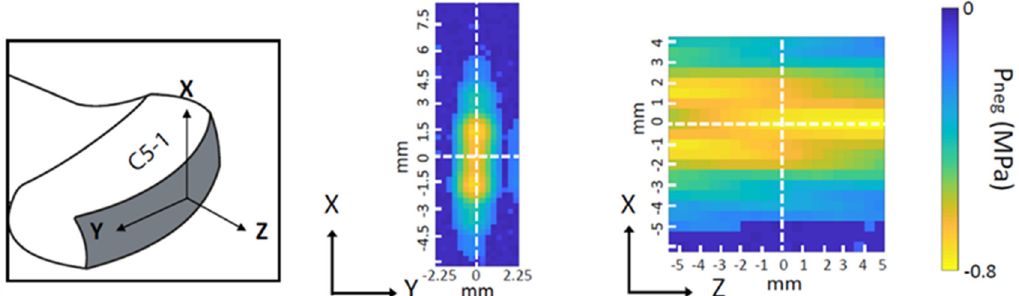
Figure 3. Pressure field maps of the C5-1 probe measured in PW Doppler mode. Middle: transversal plane, right: axial plane. Adapted from [28].